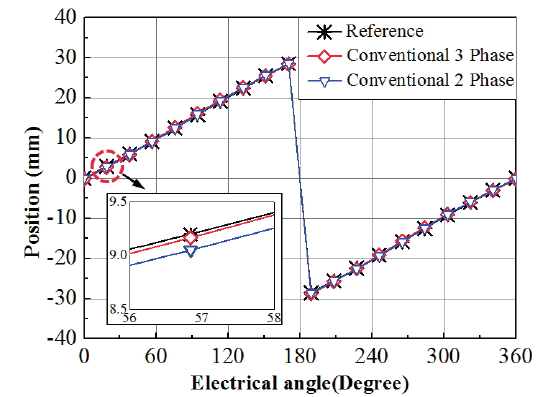
Figure 2. Simulations of the position calculation for conventional two phase and three phase sensing systems under equal amount of error in